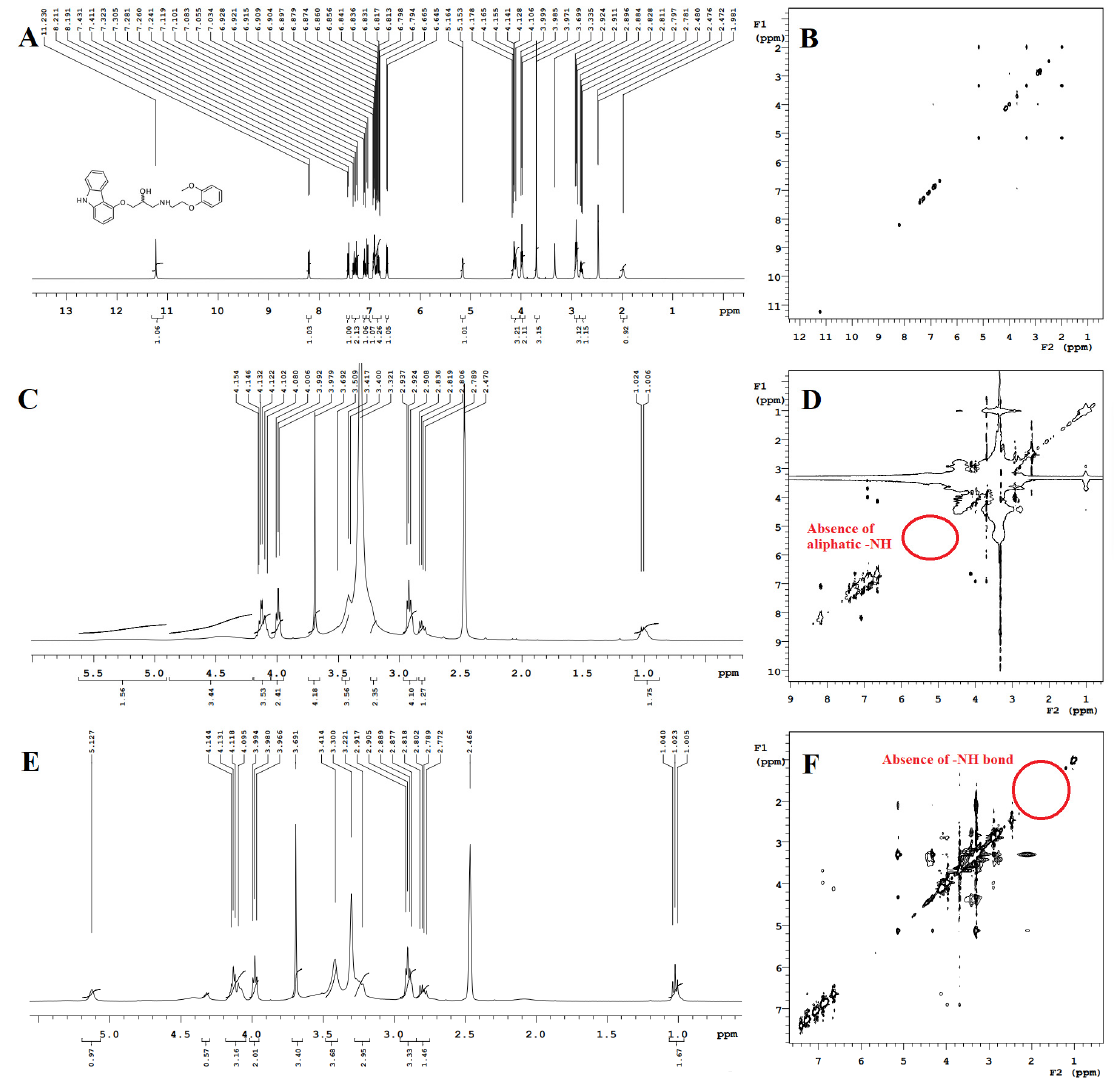
Figure 5. 1H-NMR and NOESY images of CVL ( A , B ), CVL-SDA/KM ( C , D ), and Figure 5. 1 H-NMR and NOESY images of CVL ( A , B ), CVL-SDA/KM ( C , D ), and CVL- SDC/ELV ( E , F ).